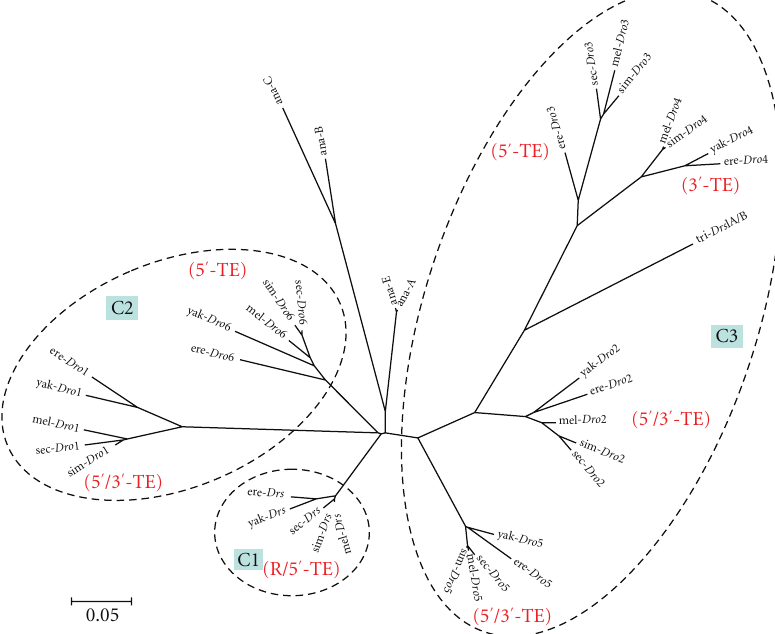
Figure 6: Neighbor-Joining tree of drosomycin gene family in Drosophila species. The tree was reconstructed by the NJ method implemented in Mega 4 with 1000 bootstrap replicates. Gaps were pairwise deleted, and the Maximum Composite Likelihood model was applied to estimate the branch length. Dot cycles with the light blue green square enclosed genes in the same cluster: the C1 is the cluster 1 at the 63D2 of 3L; C2 and C3 are the cluster 2 and cluster 3 at the 63D1 of 3L. TEs and repetitive sequence in D. melanogaster were shown in red beside each branch: R indicated the repetitive sequence, and 5 (cid:2) -TE was the TE at the 5 (cid:2) -flanking region, 3 (cid:2) -TE was the TE at the 3 (cid:2) -flanking region, and 5 (cid:2) /3 (cid:2) -TE was TEs at both flanking regions. Abbreviation for species: mel: D. melanogaster ; sim: D. simulans ; sec: D. sechellia ; yak: